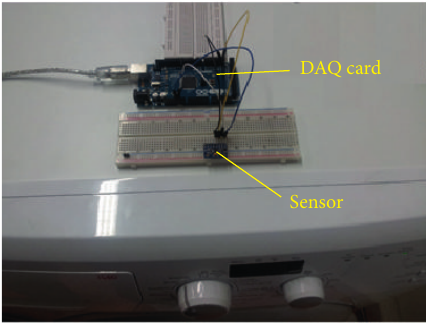
Figure 4: Sensor and DAQ card.